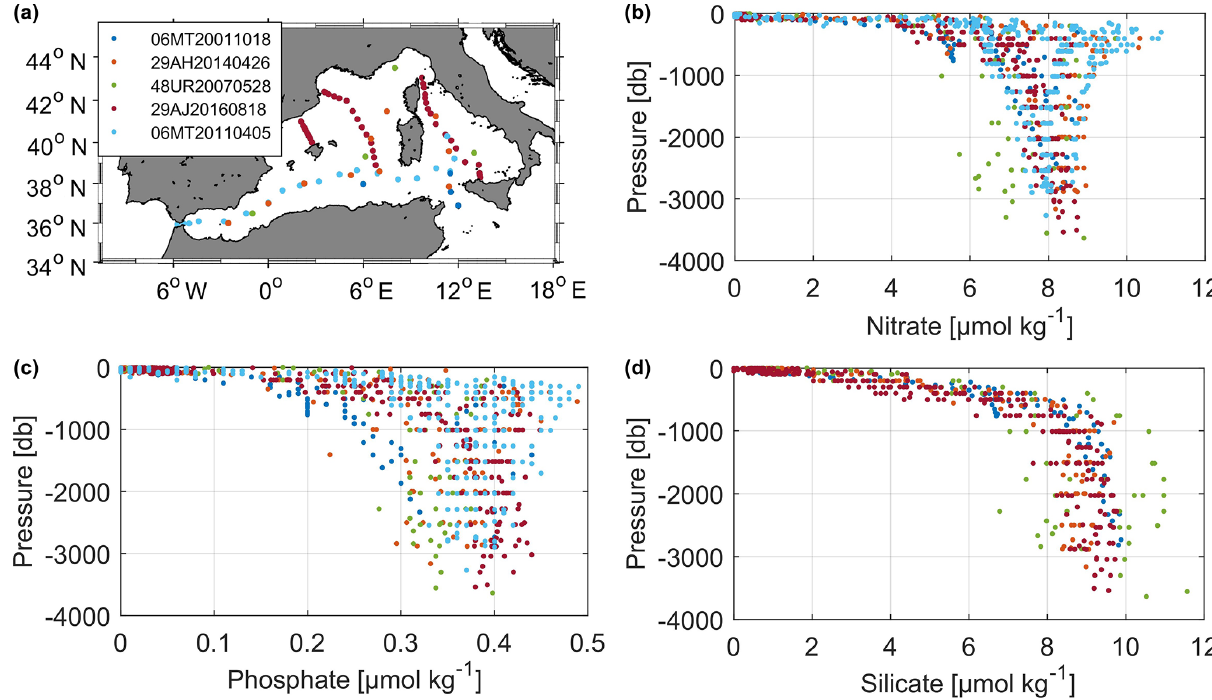
Figure 2. Overview of the reference cruise spatial coverage and vertical distributions of the inorganic nutrients. (a) Geographical distribution map; (b) vertical profiles of nitrate (µmolkg − 1 ); (c) vertical profiles of phosphate (µmolkg − 1 ); (d) vertical profiles of silicate (µmolkg − 1